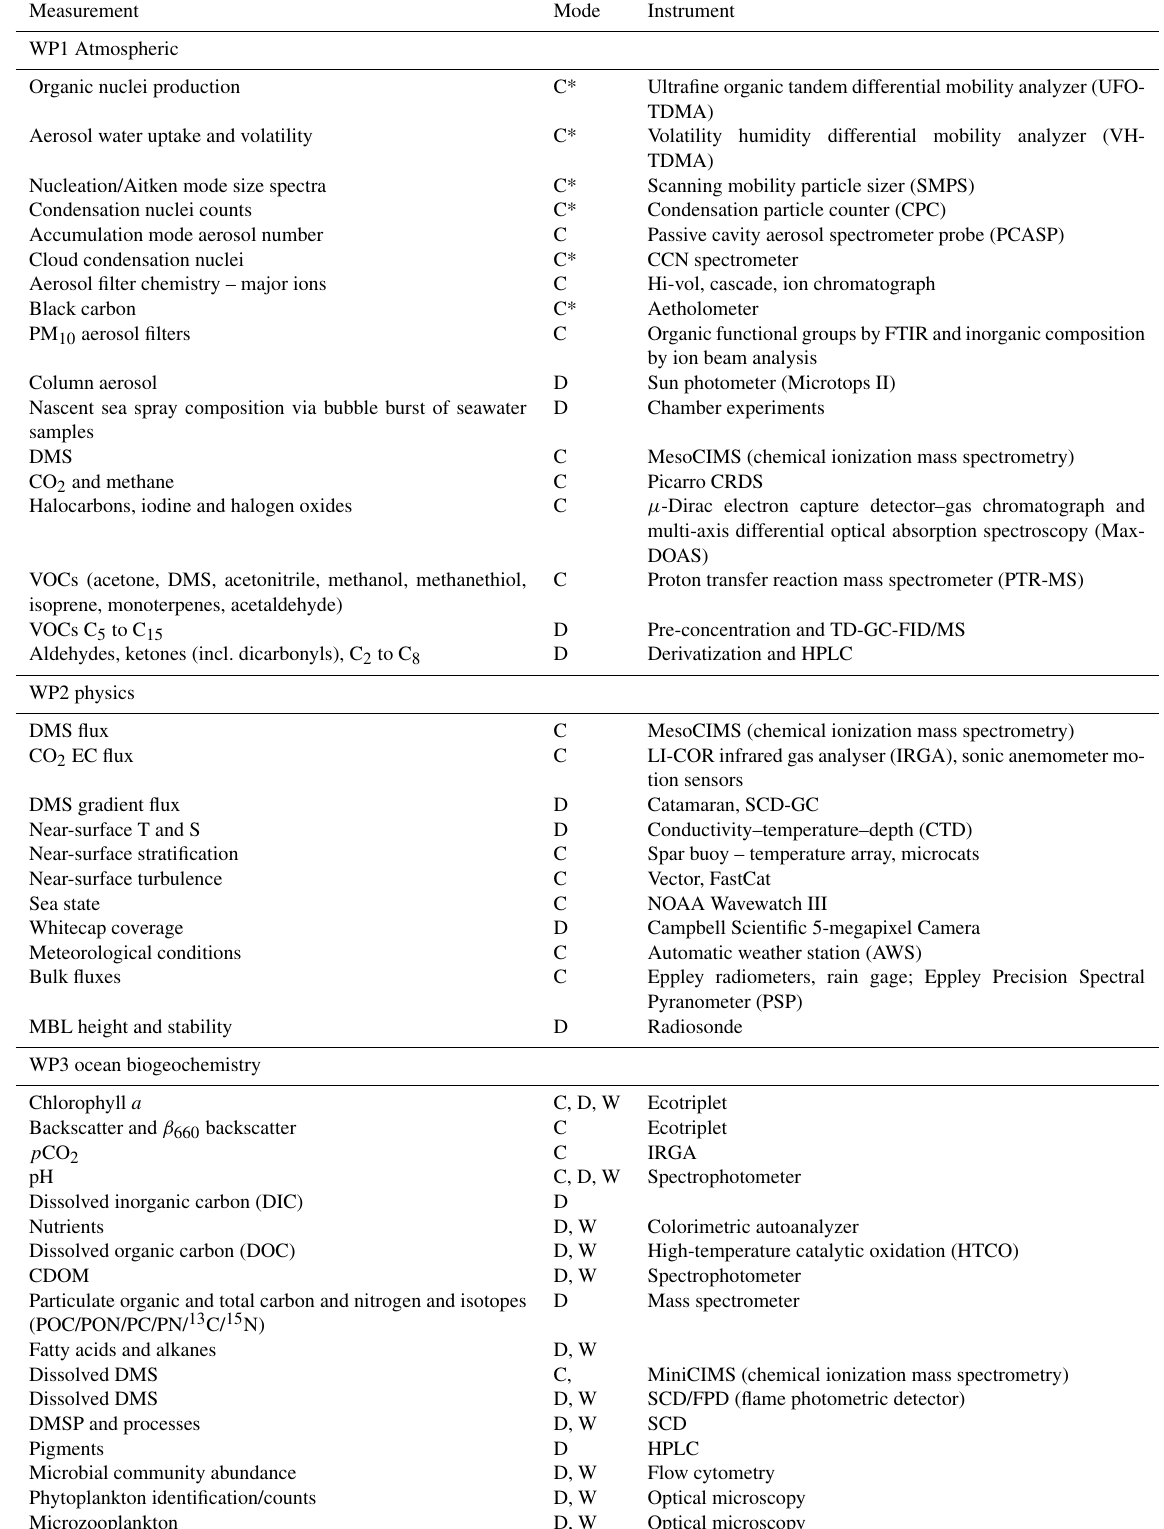
Table 2. Parameters sampled during the SOAP voyage. Key: C – continuous; D – discrete; W – workboat; *indicates instrument sampling on common aerosol